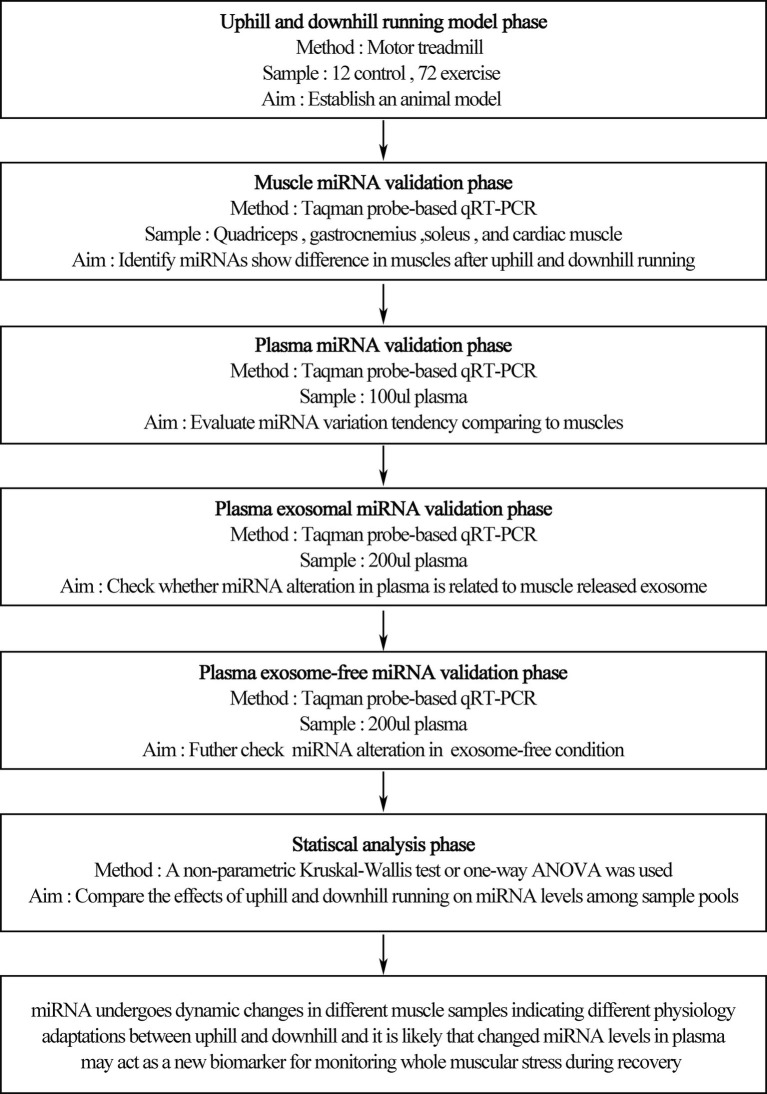
Treadmill running program. Rats underwent an acute bout of uphill and downhill running for 90 min that consisted of a speed of 20 m/min and a grade of either −15 or 15%. Blood samples, quadriceps, gastrocnemius, soleus, and cardiac muscles were collected before exercise (rest), immediately after exercise (0 h) and during recovery (1 and 48 h) of uphill and downhill running. Both groups included four time points, and each time point consisted of 12 rats.